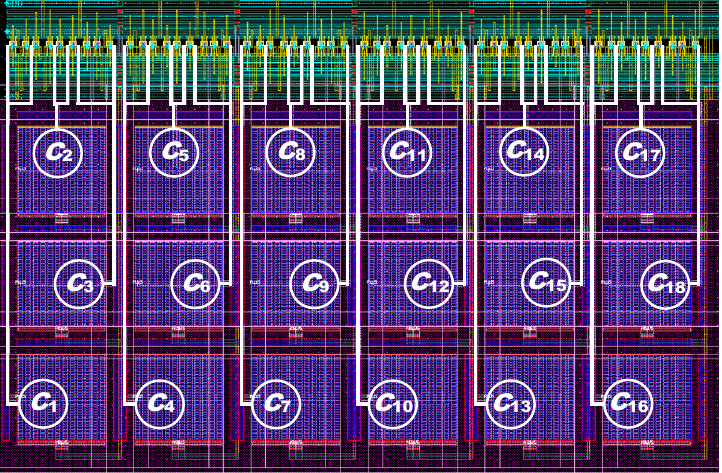
Figure 6. Routing lines between sampling capacitors and sampling switches in the positive path. White lines indicate routing lines.